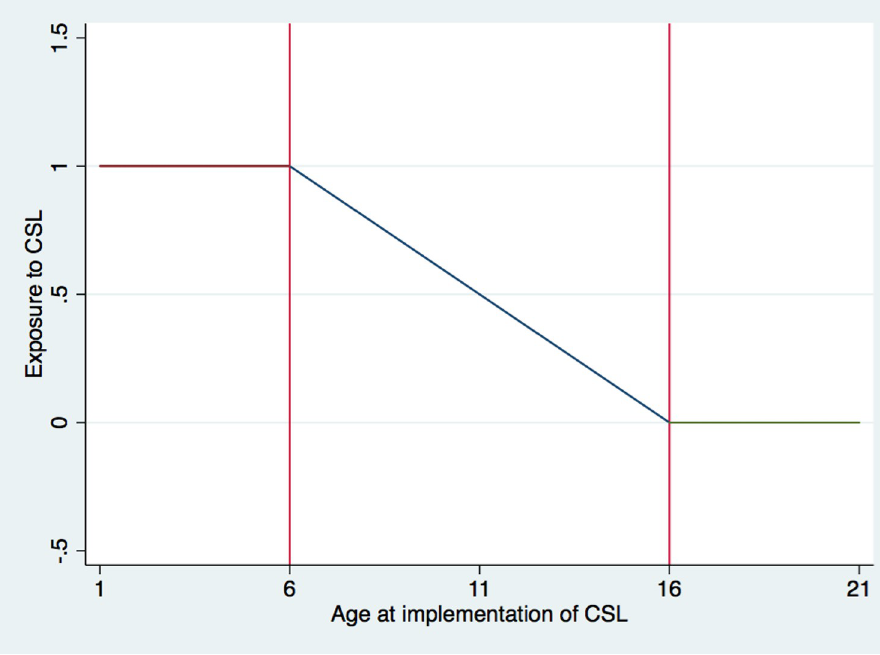
Fig 4. Construction of instrumental variable. Note: This figure illustrates the construction of instrumental variable. The X-axis is the individual age at the implementation of the CSL and the Y-axis is the individual exposure to CSL, which equals to one if the individual is fully affected by CSL (i.e. aged 6 or below) and equals to zero if the individual is unaffected by CSL (i.e. age 16 or above). A linear function is assumed for the ages in